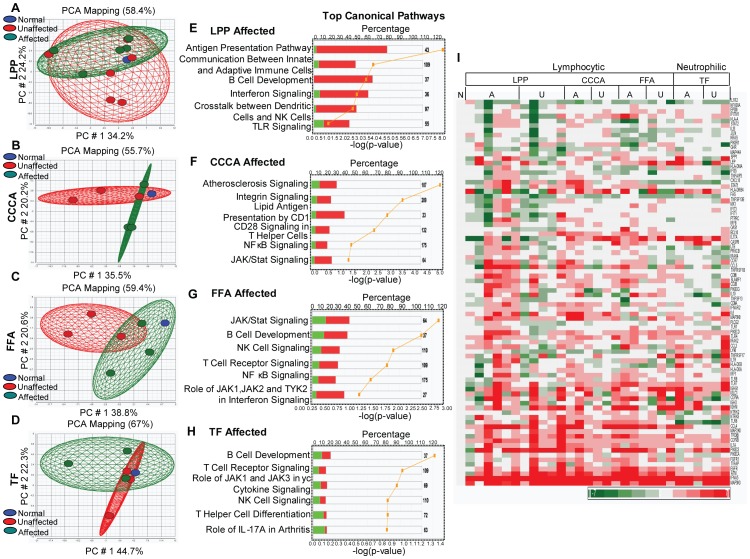
Increased expression of immune and inflammatory genes in PCA.The principal component analysis results for upregulated genes from lymphocytic (A) LPP, (B) CCCA, (C) FFA and (D) neutrophilic (TF) cicatricial alopecia are shown. The normal and unaffected samples are clustered together in each subtype, which suggests that the expression of immune and inflammatory genes is not significantly different among these samples. Most samples from affected scalp areas in patients with PCA are clustered separately from normal controls and from samples of unaffected scalp skin from PCA patients, which suggest that the expression of these genes differs between affected and unaffected samples. The top canonical pathways from gene expression profiles in patients with (E) LPP, (F) CCCA, (G) FFA and (H) TF are shown. Red represents upregulated and green represents downregulated genes in these pathways. The yellow graph line in E, F, G and H represents –log (p values). (I) Heat map of the most significantly altered immune and inflammatory genes in LPP (6 affected and 5 unaffected samples), CCCA, FFA and TF (3 affected and 3 unaffected samples each) is shown. The color bar below indicates the level of expression.